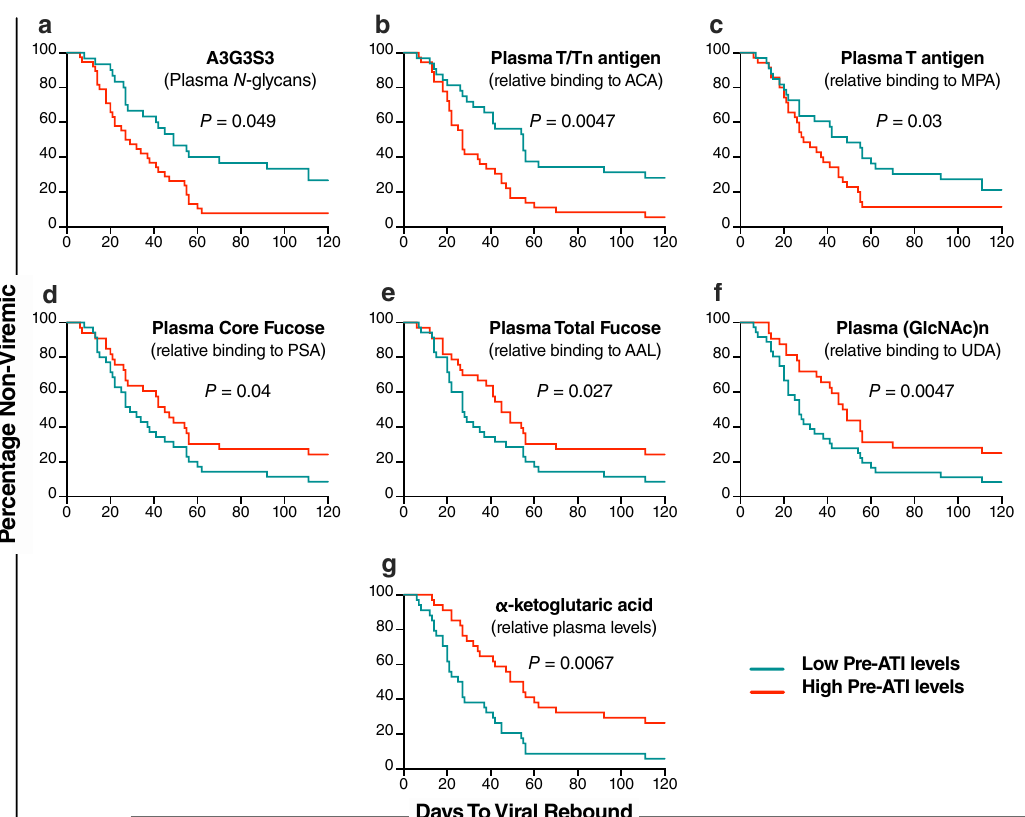
Fig. 4 Mantel – Cox plots of plasma glycomic and metabolic markers that associated with time-to-viral-rebound in the ACTG Cohort. Graphic representation of two-sided Mantel – Cox test illustrating six glycans ( a – f ) and one metabolite ( g ) that predicted time-to-viral-rebound in Fig. 3. Nominal P values are reported. Low pre-ATI levels = lower than the median; high pre-ATI levels = higher than the median. n = 74 biologically independent samples. Source data are provided as a Source Data fi